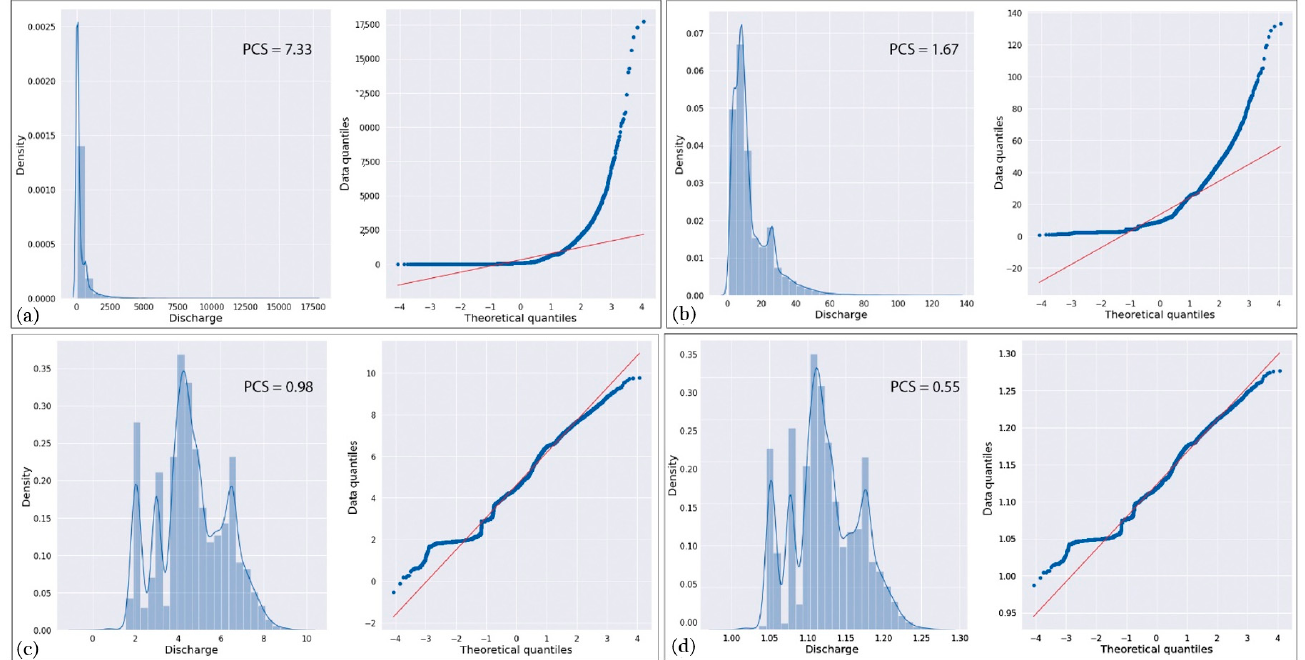
Figure 3. Multiple data transformation techniques are applied to observe the shift in the skewness, i.e., a decrease in the normality. Logarithmic transformation outperforms other transformation functions. ( a ) original data; ( b ) square-root-transformed; ( c ) cubic-transformed; ( d ) log-transformed data.